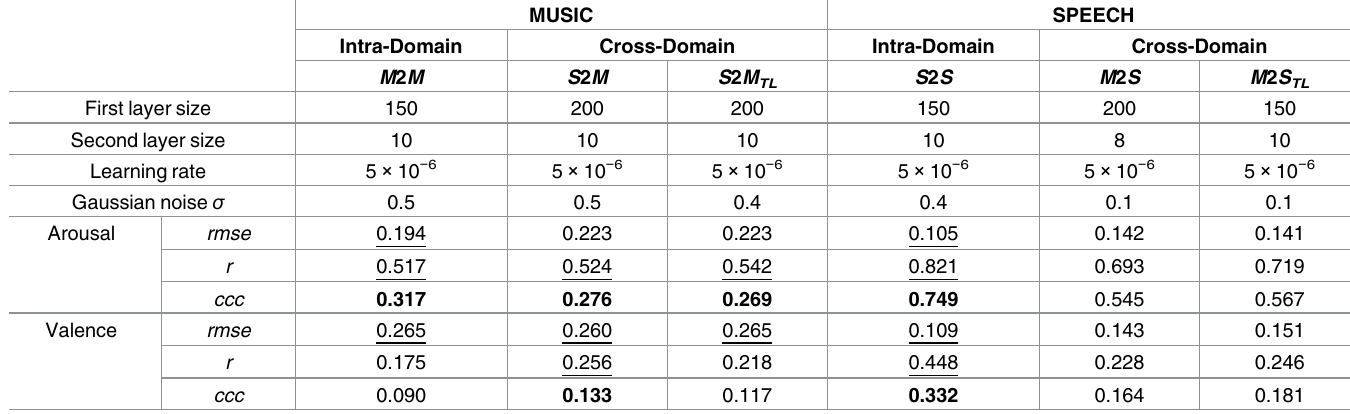
Table 6. Results obtained for the test sets of the various experimental conditions (Music on the left side, and Speech on the right). The performance of the variousapproachesis quantifiedusing the root-mean-squared-error( rmse ), Pearson’s linear correlationcoefficient r , and the concordance correlation coefficient ccc . For each experiment, the performance measures were averagedacross the five best trials. ID : intra-domain( M 2 M and S 2 S , baselinemodels trained and tested on the same database); CD : cross-domain ( S 2 M and M 2 S ); CD TL , cross-domain transfer learning( S 2 M and M 2 S ); D S ) D T (where D S is the source domain,and D T the target